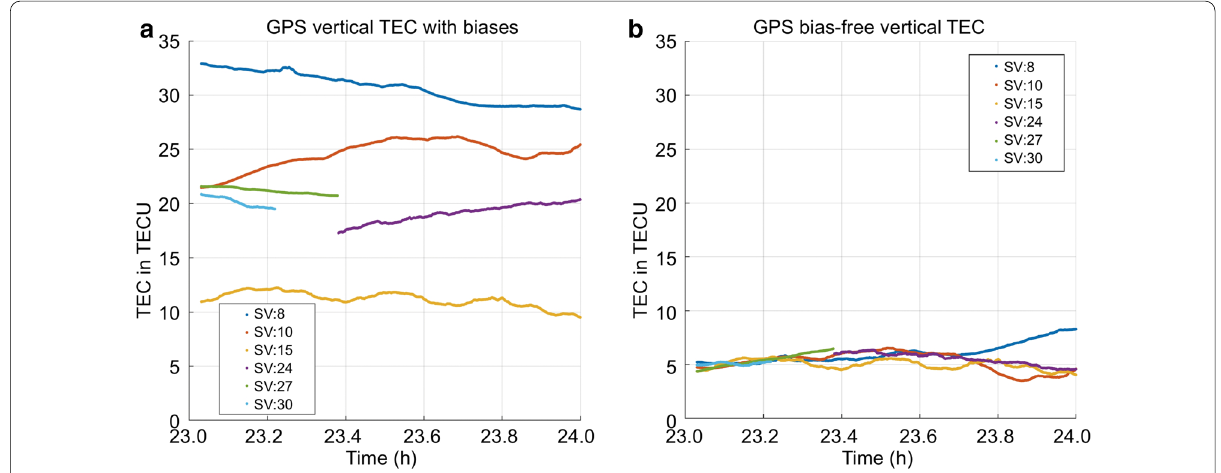
Fig. 4 GPS vertical TEC plots a DCB included b DCB